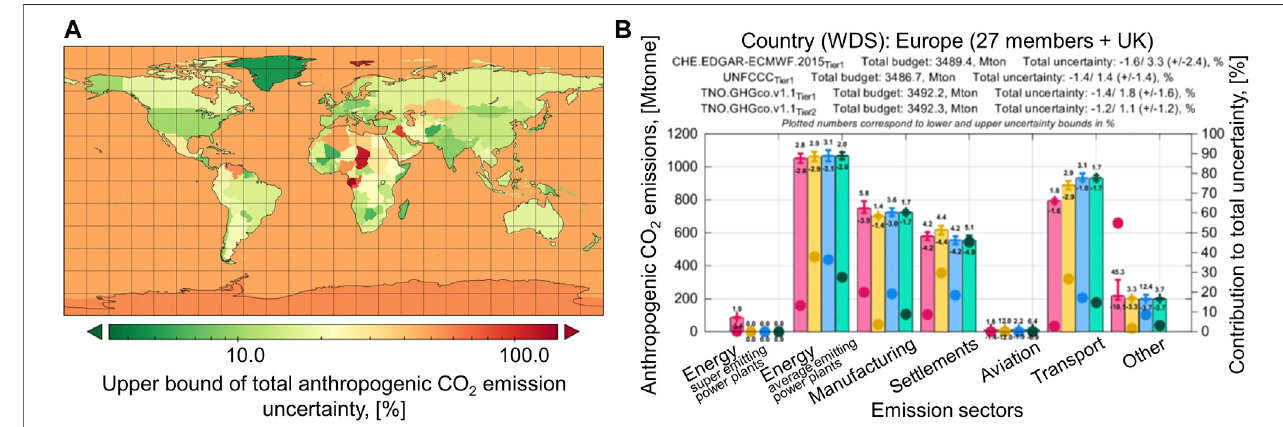
FIGURE6| UpperboundofglobalannualanthropogenicCO 2 emissionuncertainty,in%(logarithmicscale) (A) ,andillustrationofEuropeansectoralemissionswith uncertainties bounds (b) from Choulga et al.(2020). In the example ofsectoral emissionsEurope 27 + United Kingdom is shown (B) , with Energy production subdivided in super-emitters S and average emitters A, and four main emission sectors are represented for Manufacturing, Settlement, Aviation and Transport, with all remaining emission sources clustered in “ Other ” .